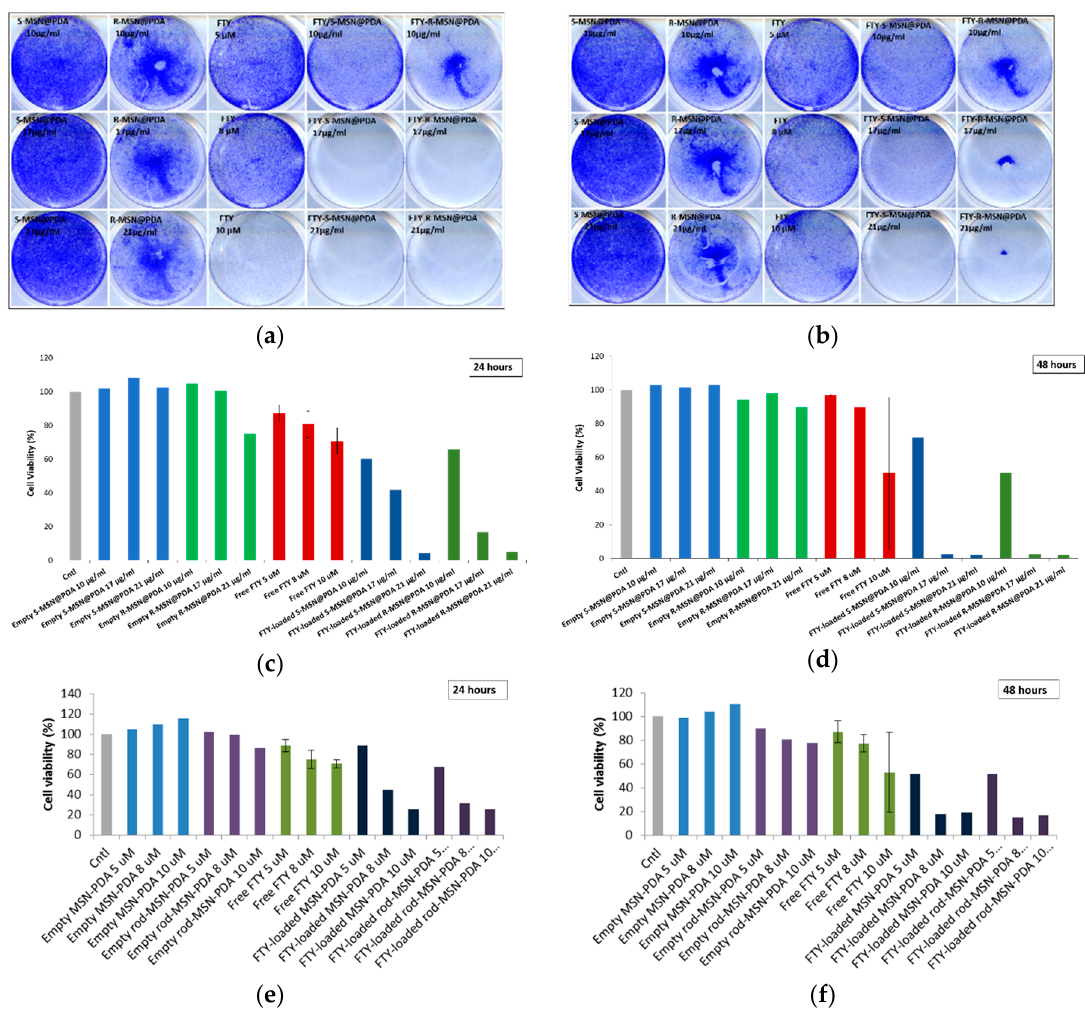
Figure 7. Cell viability of ML-1 cells is represented using crystal violet assay against the cytotoxic e ff ect of FTY720-loaded MSN@PDA particles. The top row ( a , b ) shows the well plates used for treating ML-1 cells with FTY720-loaded MSN@PDA particles and free FTY720. The bottom rows show the cytotoxicity of empty and FTY720-loaded S-MSN@PDA, R-MSN@PDA, and corresponding concentrations of free FTY720 in ML-1 cells, analyzed using the Colony Area plugin in ImageJ ( c , d ) and plate reader ( e , f ) at 24 and 48 h of incubation. Negative control indicates untreated cells, while positive control indicates cells treated with 0.1% Triton X-100.